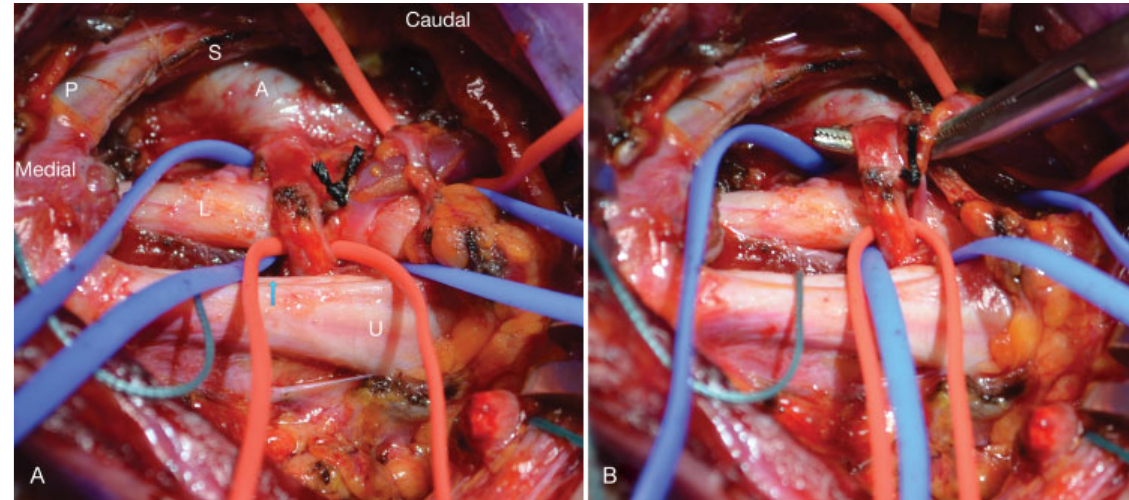
Fig. 1 First case. ( A ) Right brachial plexus exposure showing compression of the lower trunk of the brachial plexus (L) by a branch from the subclavian artery (A) and a vein. Scalenus anterior muscle edge after partial scalenectomy (S), phrenic nerve (P), upper trunk (U), middle trunk (blue arrow). ( B ) A right-angled instrument is used to lift upthe vessels off the lower trunkof the brachial plexus. Shredded Te fl on is then used for separation.